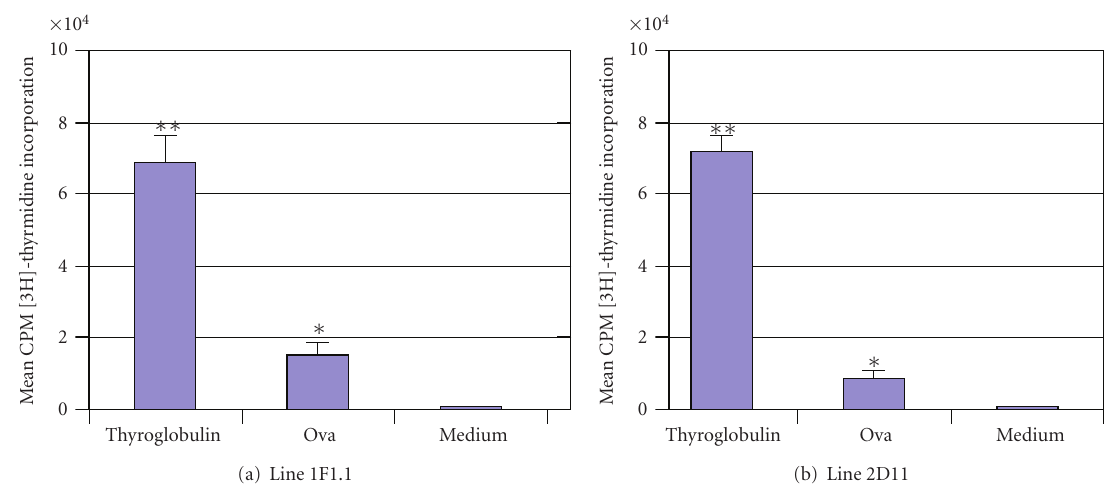
Figure 3: In vitro response of iNKT cells to thyroglobulin. A 72-hour proliferation assay was performed in response to 45 μ g/mL of thyroglobulin. [3H]-thymidine incorporation was used as an indicator of stimulation response. Both cell lines showed a significantly higher proliferation in response to thyroglobulin. A few cells also proliferated in response to Ovalbumin (Ova). Results are expressed as mean counts/4 minutes of [3H]-thyrmidine uptake. (Representative of 3 independent experiments).